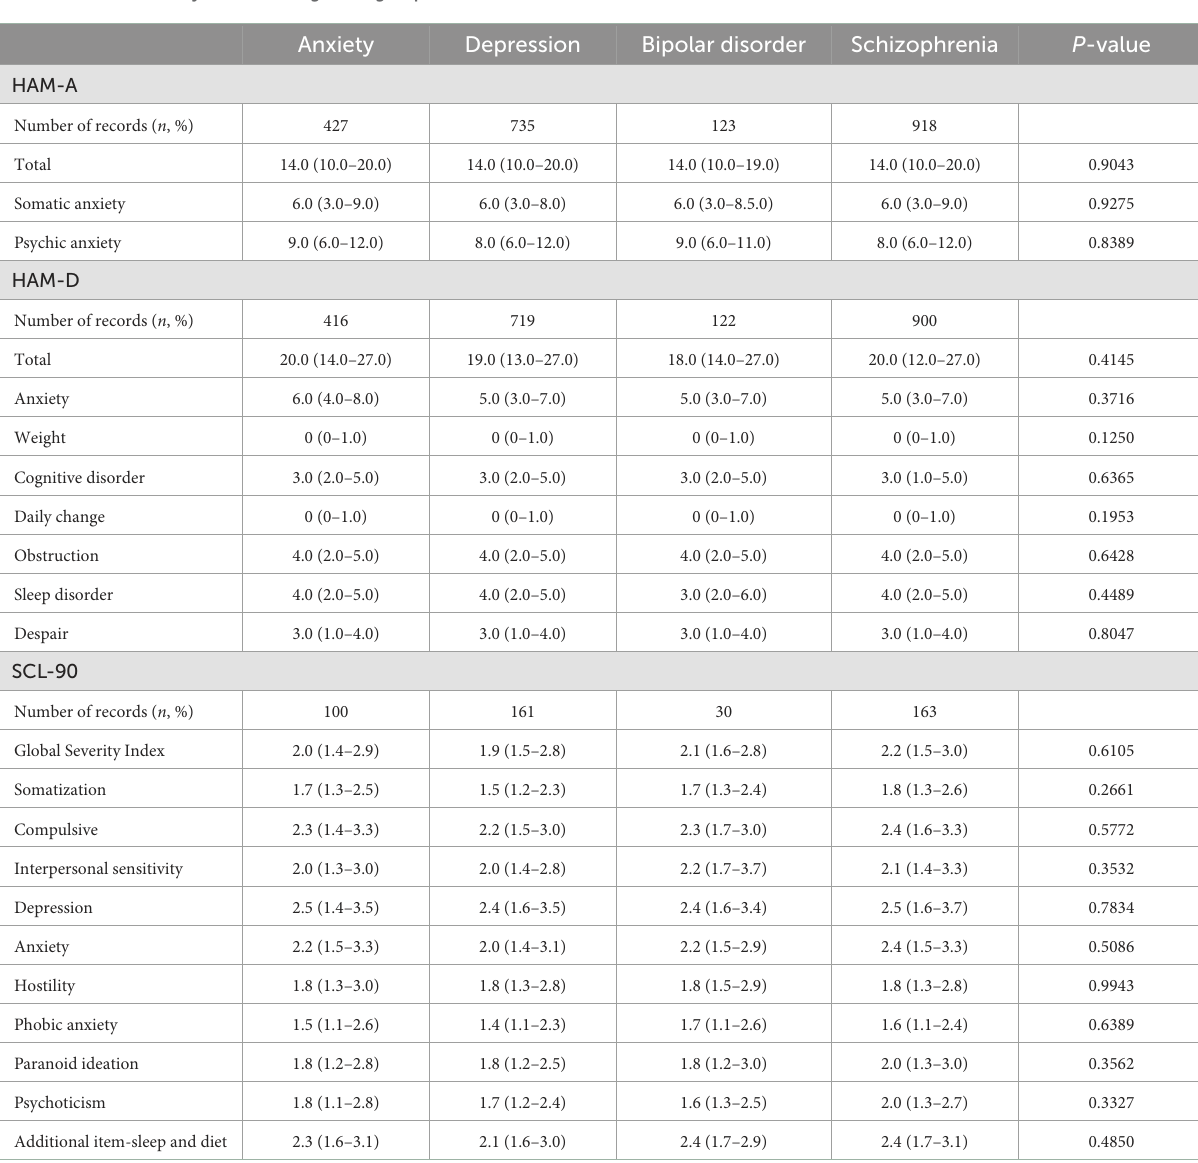
TABLE 4 Mann–Whitney U test for diagnostic groups. Anxiety Depression Bipolar disorder Schizophrenia P